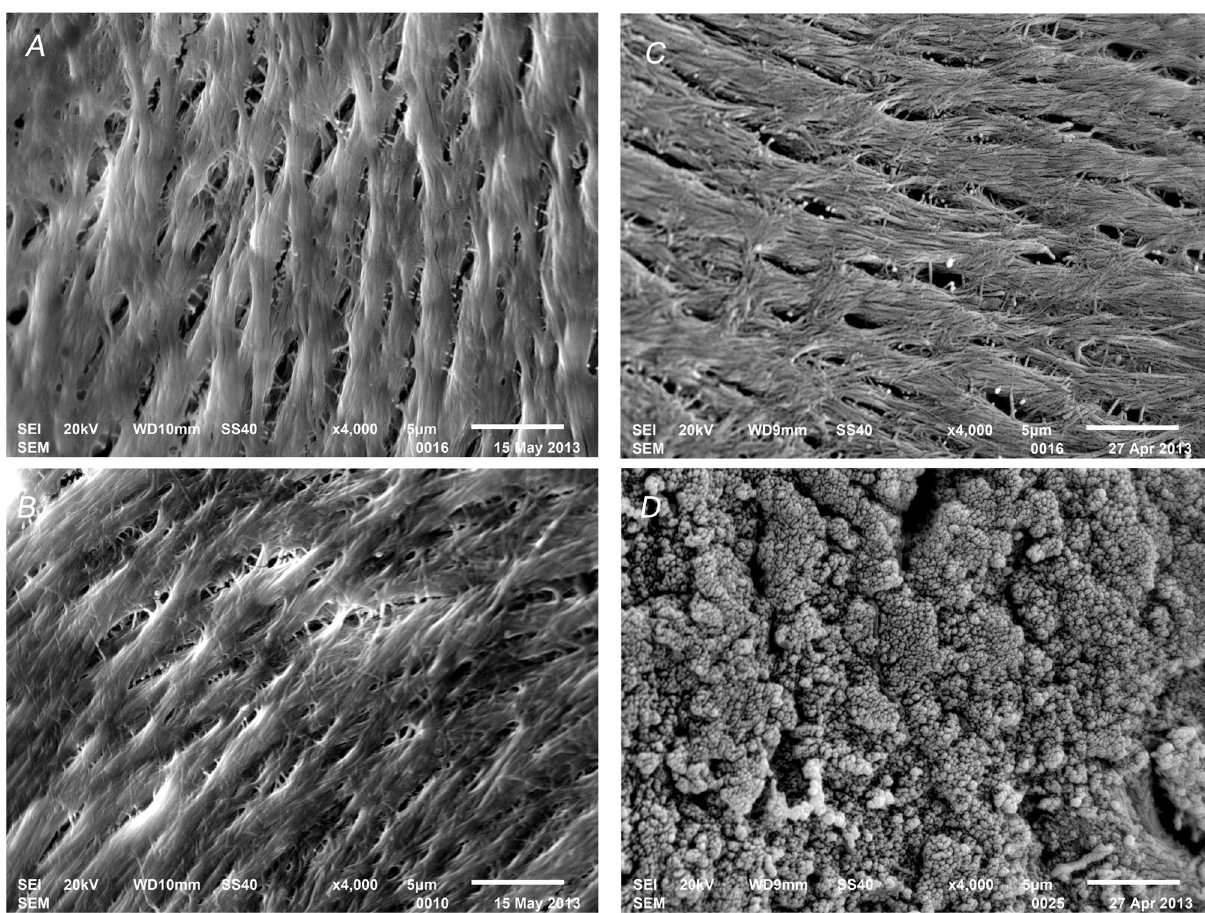
Figure 5. Surface analysis of samples by SEM before and after soaking in SBF